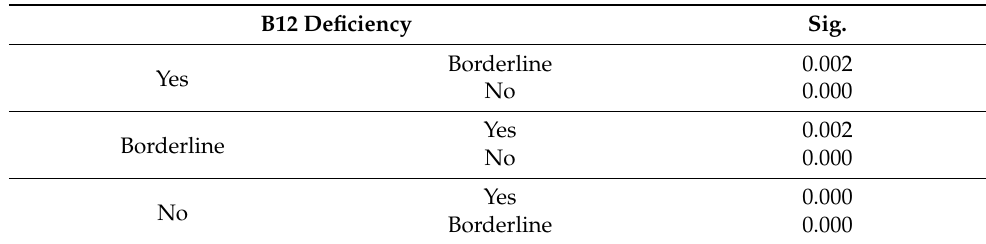
Table 3. Post-hoc (Tukey’s Honest Significant Difference) for intergroup comparison of patients on The relationship between neuropathy score (Toronto clinical scoring system (TCSS)) metformin. and metformin use is shown in Table